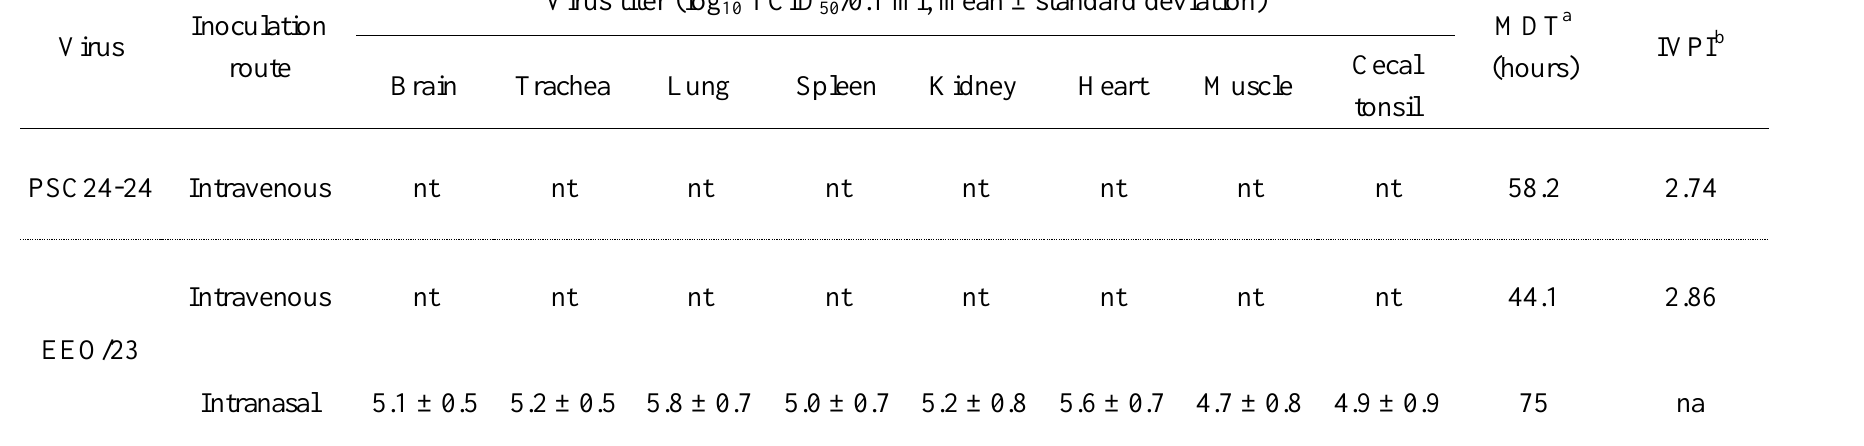
Table 2. Pathogenicity and virus distribution of the Korean H5N1 HPAI viruses in